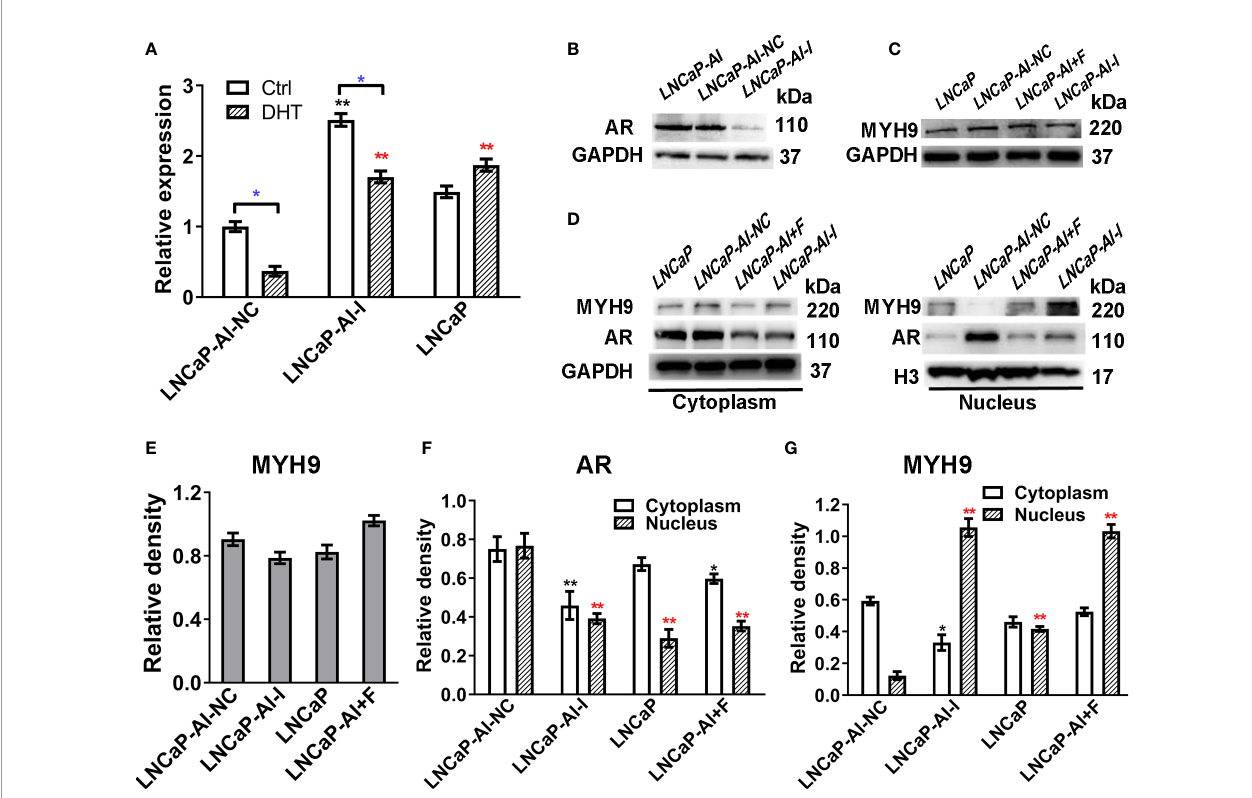
FIGURE 7 | The nuclear translocation of MYH9 was enhanced after AR interference. (A) qRT-PCR analysis of MYH9 mRNA was assessed following serum starvation for 48 h before treatment with 10 nM DHT or equal amounts of ethanol for 24 h in the four cell lines. The results are expressed as the mean ± S.D. of three biological replicates, and * indicates a signi fi cant difference from the controls (*, P<0.05; one-way ANOVA followed by LSD multiple comparison test and T test for the same cell line treated with alcohol or 10 nM DHT). LNCaP-AI cells were transfected with AR shRNA (LNCaP-AI-I) or scrambled lentiviral particles (LNCaP-AI- NC), and lysates were blotted for AR (B) and MYH9 (C) . (D) MYH9 or AR nuclear and cytoplasmic fractions were blotted for detection. (E) The density of each MYH9 band in three independent experiments of (C) was determined. (F, G) The density of AR and MYH9 in three independent experiments of (D) was determined by ImageJ 1.52i software (National Institutes of Health, USA) and AR or MYH9 levels were normalized to GAPDH (cytoplasm) or H3 (nucleus) (*P < 0.05, **P < 0.01; one-way ANOVA followed by Dunnett ’ s test compared with LNCaP-AI-NC cells, n=3). The experiment was performed in triplicate and a representative experiment is